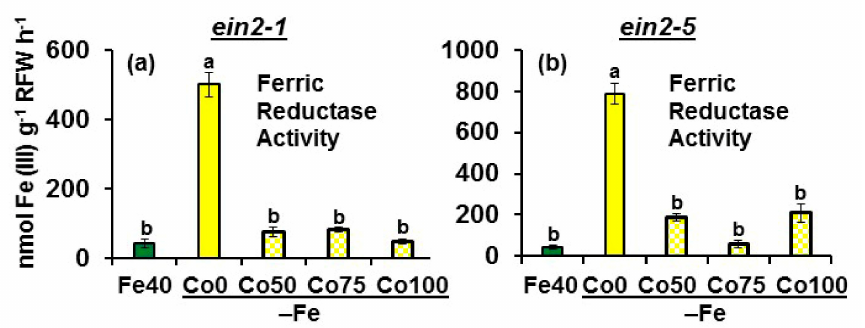
Figure 3. Effect of Fe deficiency and cobalt (Co; an ET synthesis inhibitor) on the ferric reductase activity (FRA) of the Arabidopsis ET insensitive ein2-1 ( a ) and ein2-5 ( b ) plants. Treatments as in Figure 2. After treatments, FRA was determined. Data represent the mean of 6 replicates ± S.E. Bars with different letters indicate significant differences ( p < 0.05) according to the Tukey’s